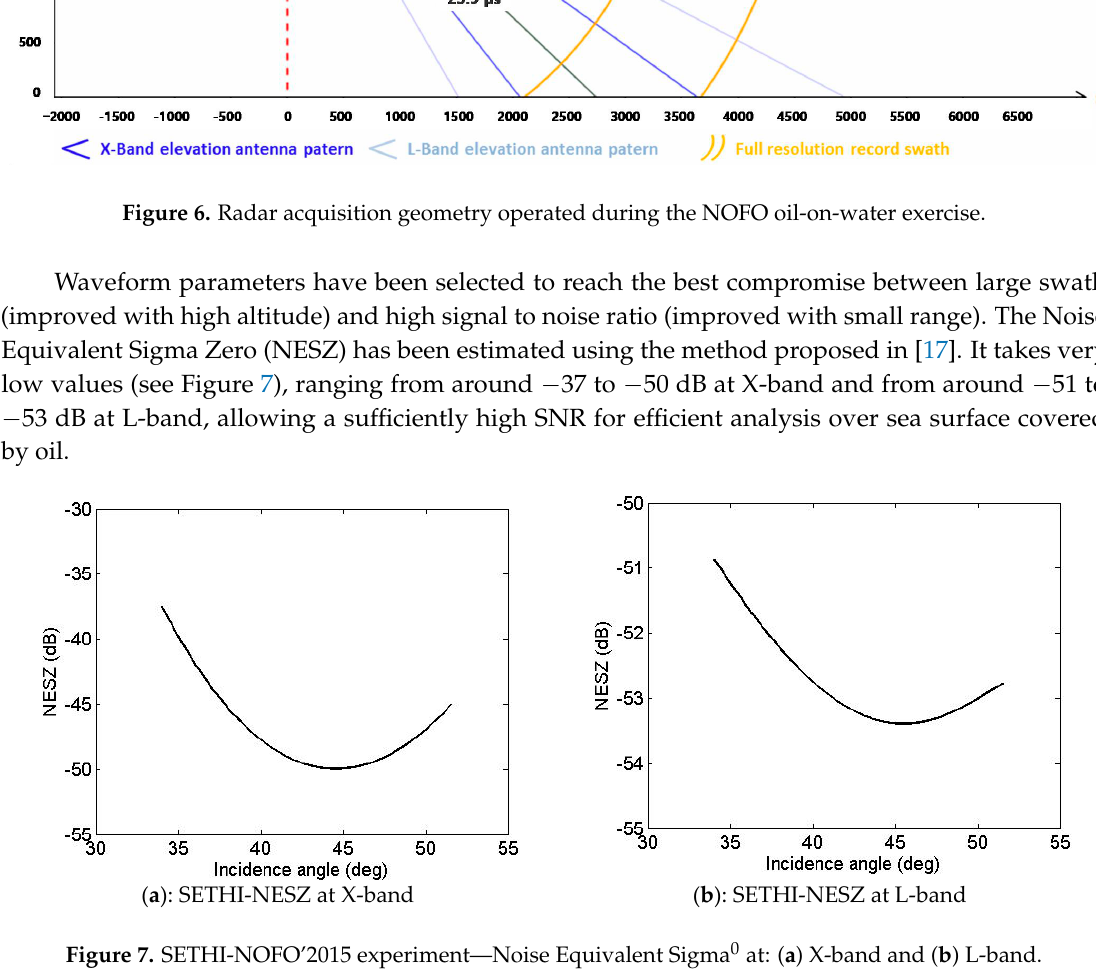
Figure 6. Radar acquisition geometry operated during the NOFO oil-on-water exercise.